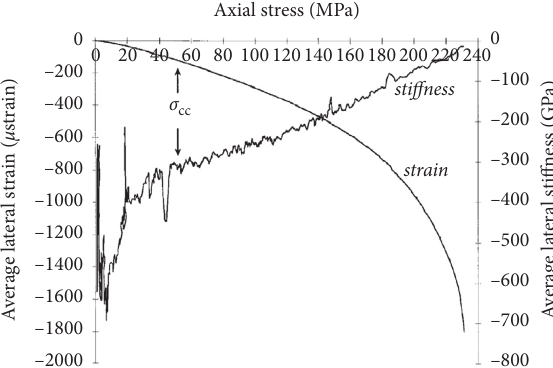
Figure 11: Lateral strain curve and lateral deformation stiffness of Canadian URLAE pink granite